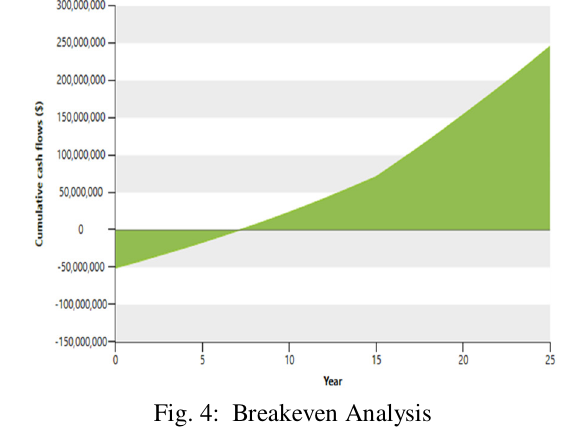
Table 5: Fixed and variable costs